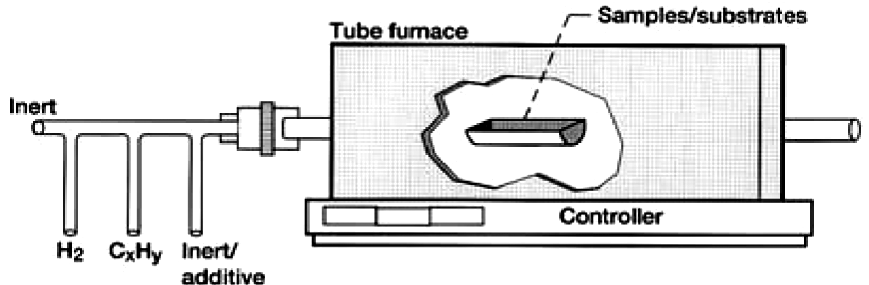
Figure 2. Schematic of the experimental setup for TEC synthesis of